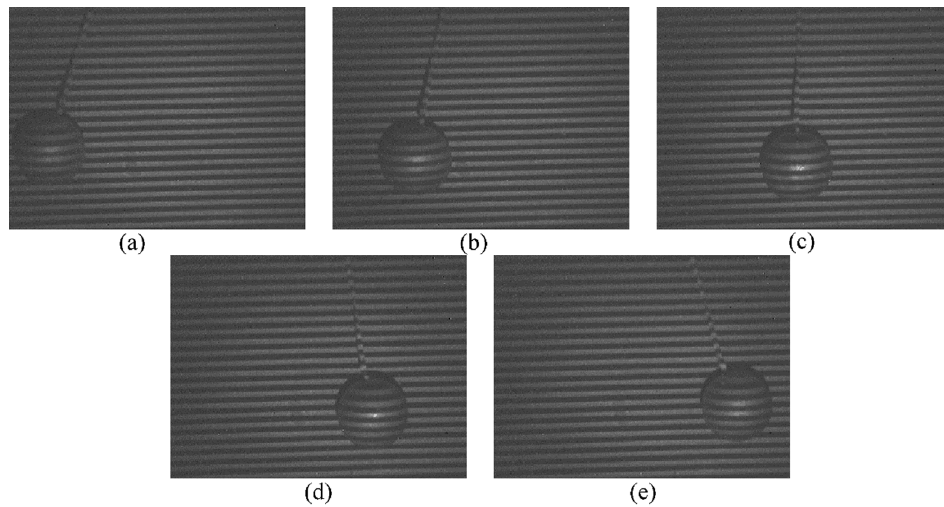
Figure 6. 2D deformed fringe patterns of the pendulum ball at frames ( a ) 6, ( b ) 9, ( c ) 12, ( d ) 15, ( e )